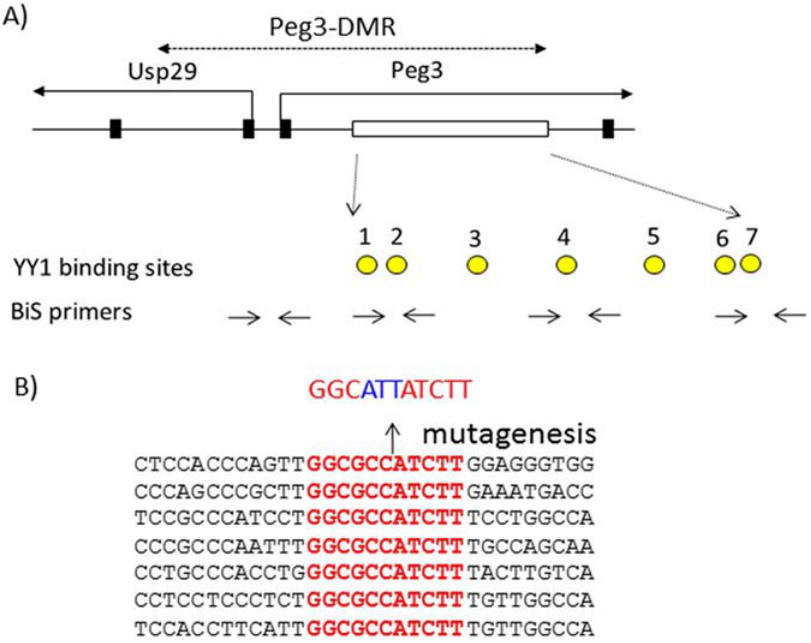
Figure 1. 7 YY1 binding sites localized within the Peg3-DMR. ( A ) The 4-kb genomic region corresponding to the Peg3-DMR is indicated with a dotted line with arrows. The 1 st and 2 nd exons of both Peg3 and Usp29 are indicated with thick vertical lines, whereas the 2.5-kb YY1 binding region is indicated with an open box. The relative positions of the 7 YY1 binding sites are indicated with circles, and the positions of several sets of BiS (Bisulfite Sequencing) primers for DNA methylation analyses are indicated with arrows. ( B ) The sequence of the 7 YY1 binding sites are shown along with the flanking sequences. The sequences of the 7 YY1 binding sites with red are identical to each other. The three bases of each YY1 binding site were mutated from 5 ′ -GCC-3 ′ to 5 ′ -ATT-3 ′